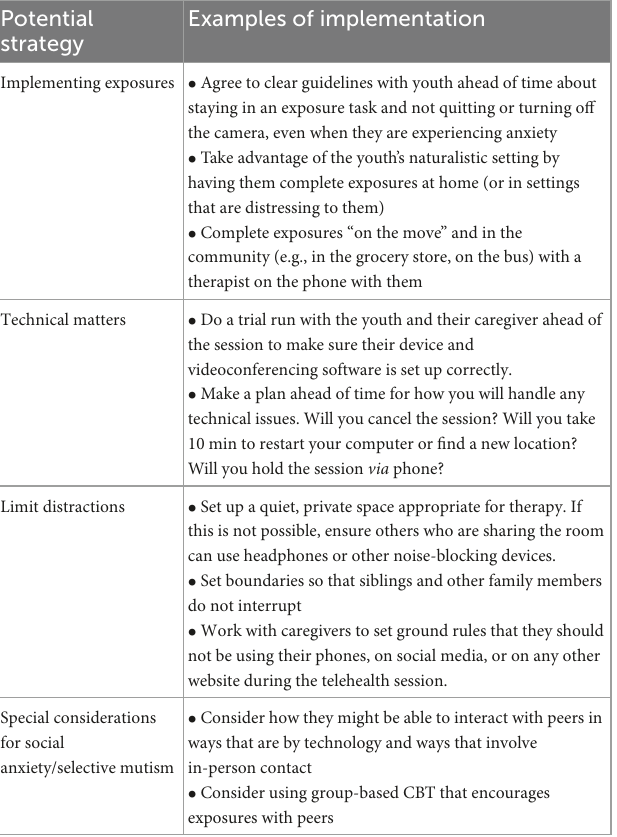
TABLE 3 Administering CBT for youth anxiety through telehealth. Potential Examples of strategy